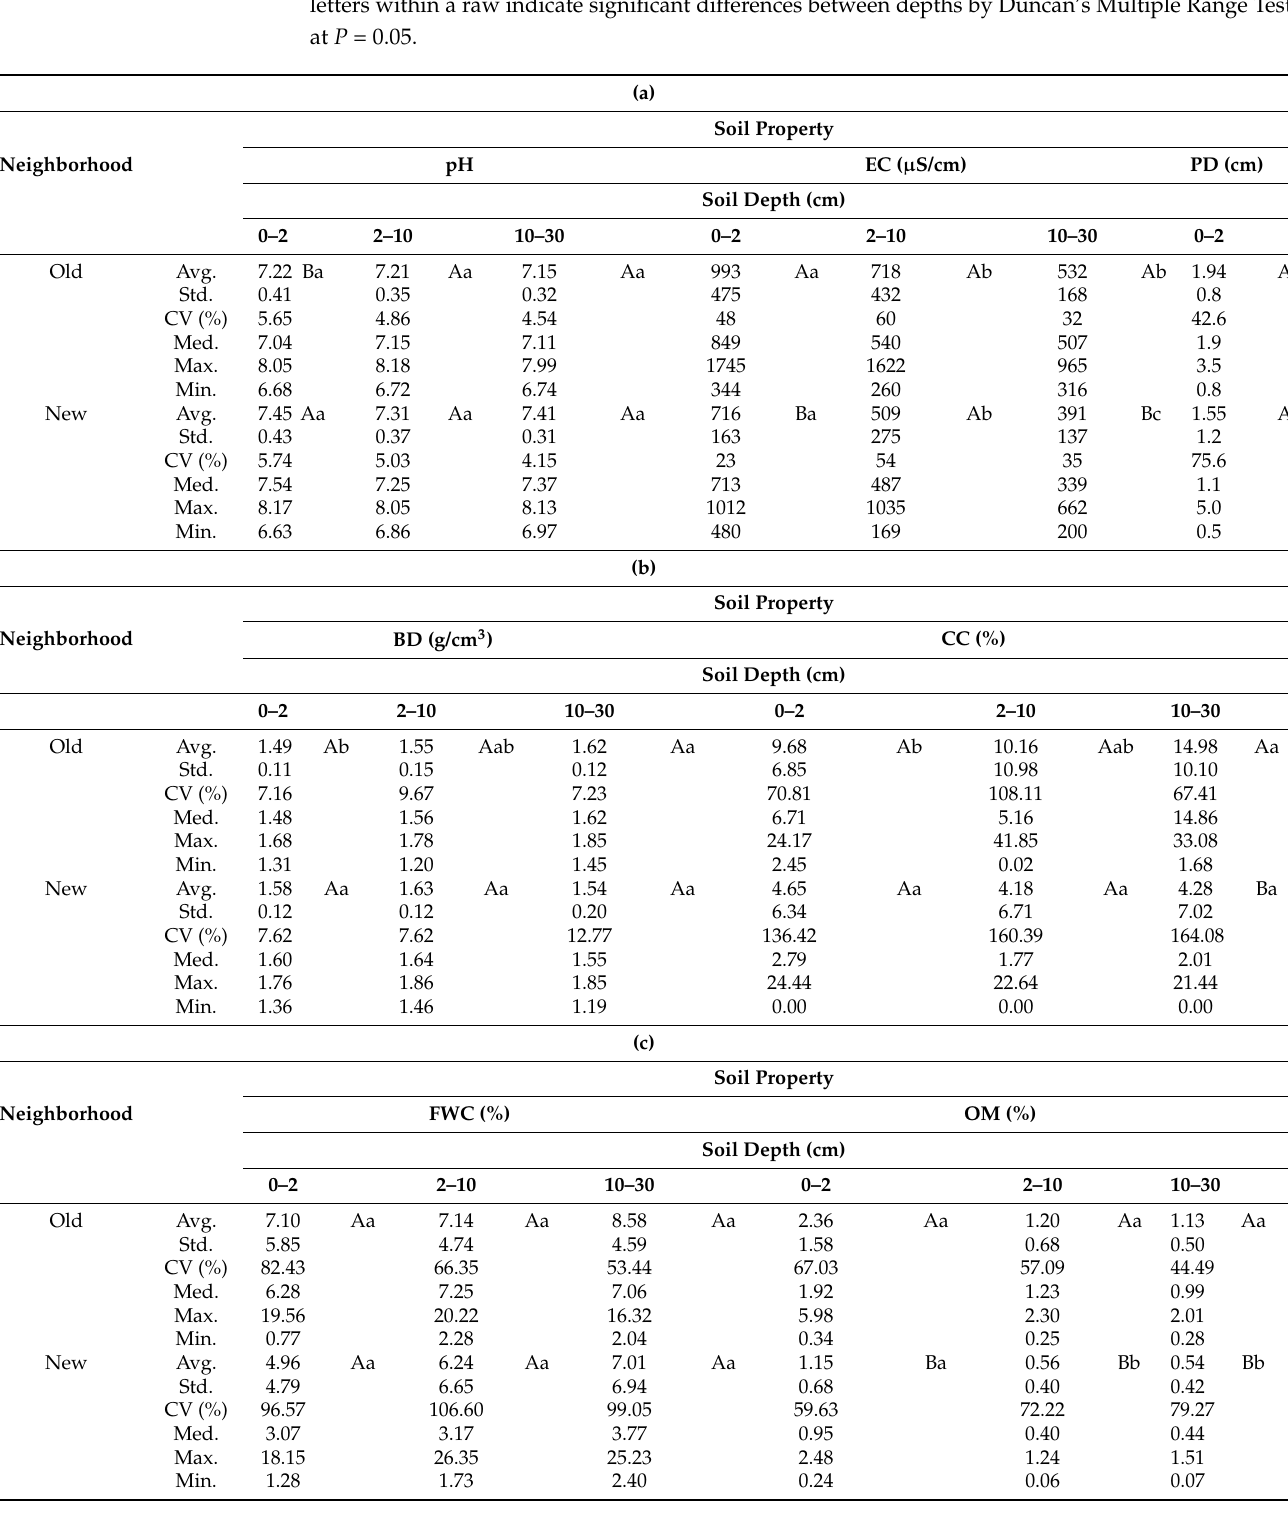
Table 1. Statistical parameters of different soil properties at the gardens of two city